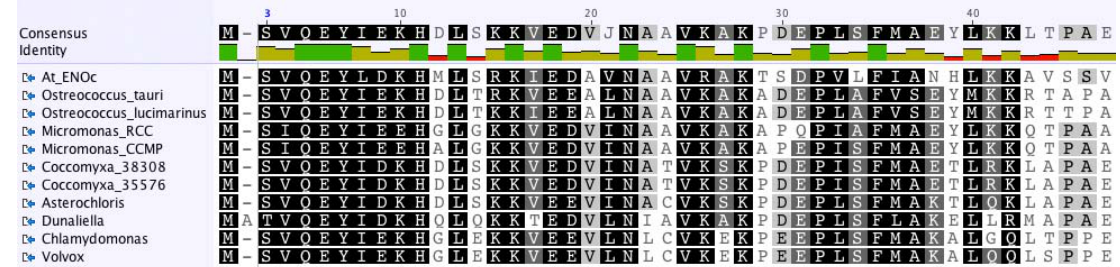
Figure 3. Shown is an overview of a MUSCLE [67] alignment (Score Matrix = Blossum62) of the N-terminus of enolase protein sequences from selected green algae and of ENOc of the higher plant A . thaliana . The P . provasolii enolase proteins were not included in this Figure, because the N-terminal sequences are not known. Color code: Black = 100% similar; Dark Gray = 80%–100% similar; Light Gray = 60%–80% similar; White = less than 60% similar.